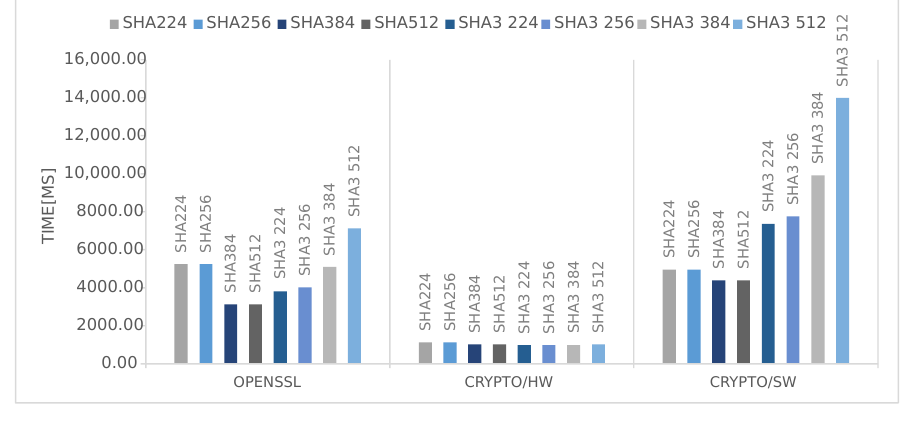
Figure 6. Time required by each SHA algorithm for a 5 MB file.